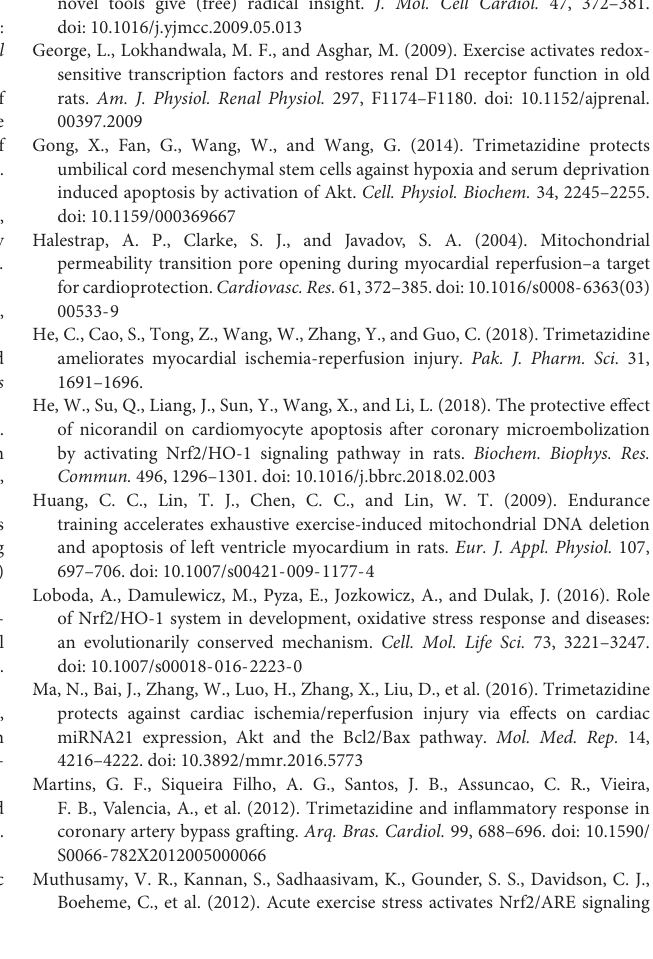
FIGURE S1 | TMZ repressed EE-induced changes in cardiac function in rats. The heart rate (A) , left ventricular end-syssolic pressure (B) , left ventricular end-diastolic pressure (C) , left ventricular end-syssolic volume (D) , left ventricular end-diastolic volume (E) , ejection fraction (F) , and cardiac output (G) are shown. Each value is shown as mean ± SD ( n = 6). ∗∗ P < 0.01, ∗∗∗ P < 0.001, versus the indicated